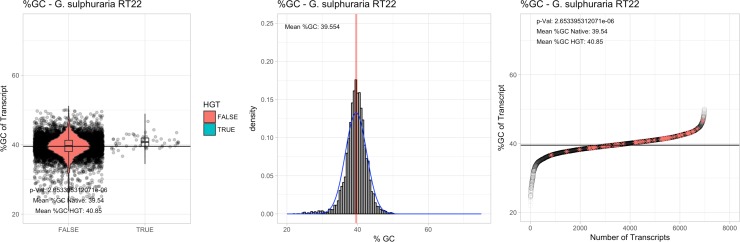
%GC – Galdieria sulphuraria RT22: (Left) Violin plot showing the %GC distribution across native transcripts and HGT candidates.(Mid) Cumulative %GC distribution of transcripts. Red line shows the average, blue line a normal distribution based on the average value. (Right) Ranking all transcripts based upon their %GC content. Red ‘*' demarks HGT candidates. As the %GC content was normally distributed, students test was applied for the determination of significant differences between the native gene and the HGT candidate subset.